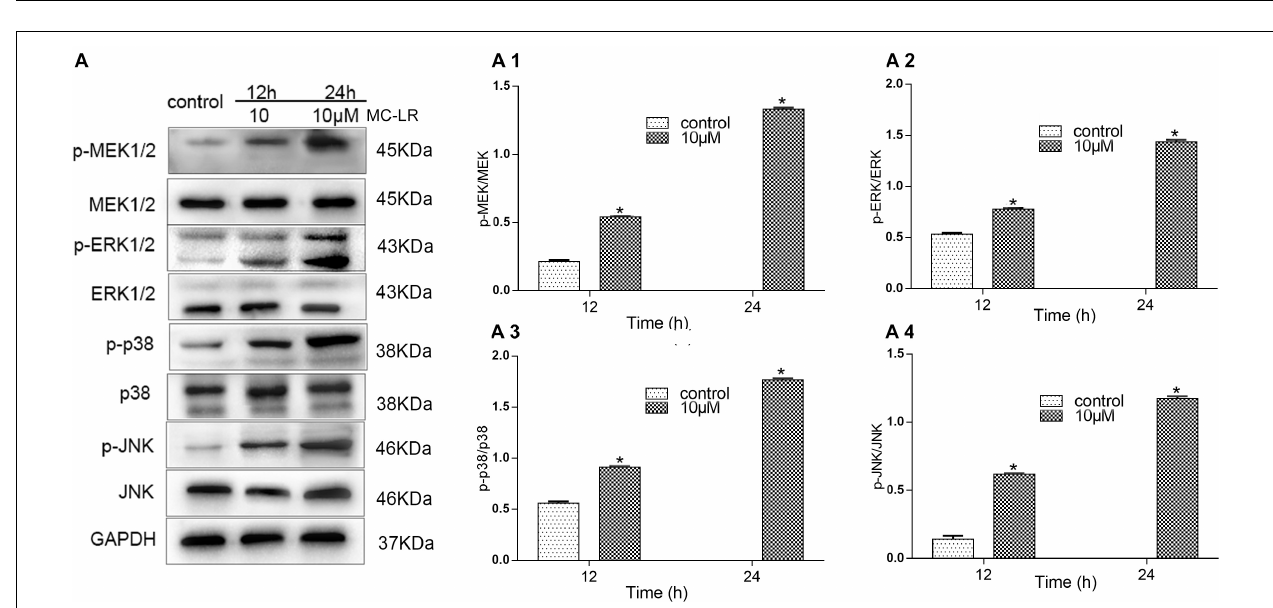
FIGURE 6 | Effect of MC-LR and ctHBx on the cell cycle and apoptosis of HepG2 cells. The cell cycle analysis showed that the HBx (cid:49) 32 and HBx (cid:49) 4 groups exposed to MC-LR (10 µ M) included a greater proportion of cells in the S phase than the NC, HBx, and HepG2 groups exposed to MC-LR (HBx (cid:49) 32 vs. HBx P < 0.05; HBx (cid:49) 4 vs. HBx P < 0.05). (A) The apoptosis rates of the HBx (cid:49) 32, HBx (cid:49) 4, and HBx groups exposed to MC-LR (10 µ M) were not significantly different from those of the NC and HepG2 groups exposed to MC-LR ( F = 0.119, P = 0.890). (B) Bar graphs indicate means ± standard deviation from three independent experiments. * P < 0.05 vs. 0 µ M MC-LR.